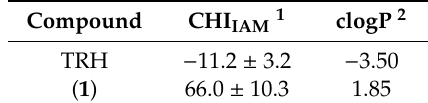
Table 1. Prediction of blood-brain barrier (BBB) permeability of prodrug ( 1 ) versus TRH. CHI IAM was determined according to Valko et al. [29], while clogP was calculated using an atom-typing additive method